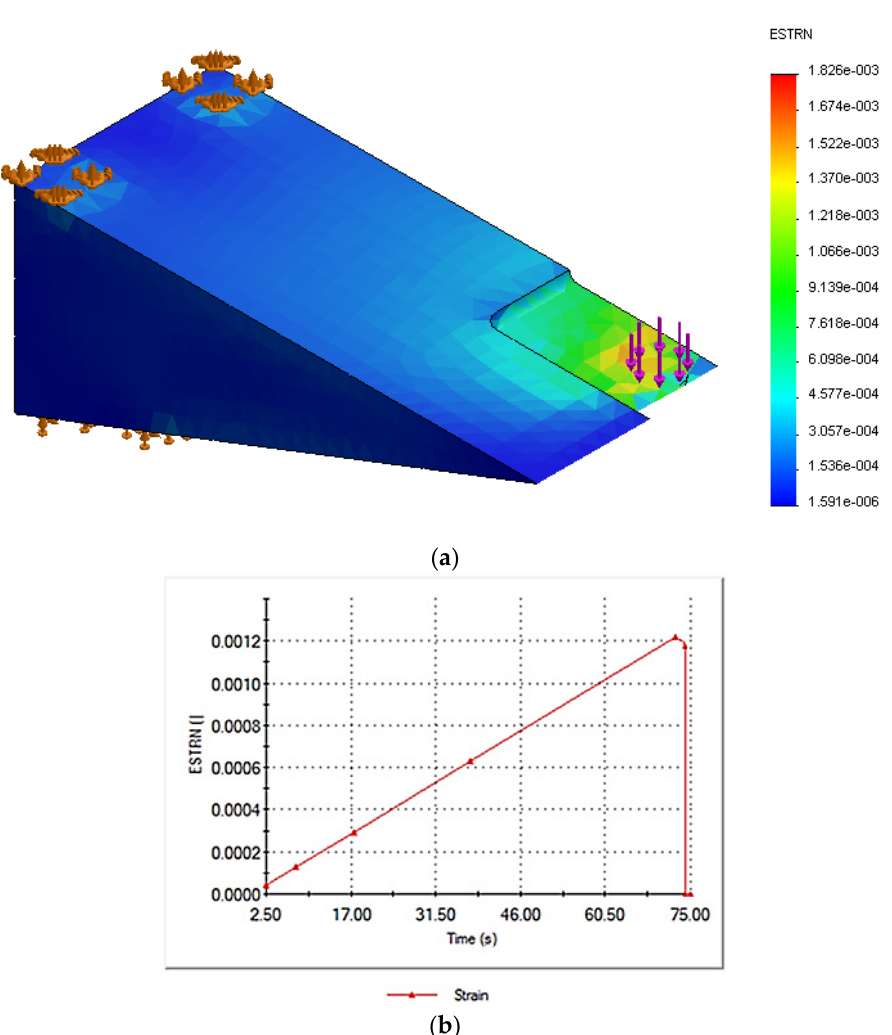
Figure 10. ( a ) Three-dimensional (3D) model highlighting equivalent strain; ( b ) equivalent strain vs. time for the model with 2 mm cut.